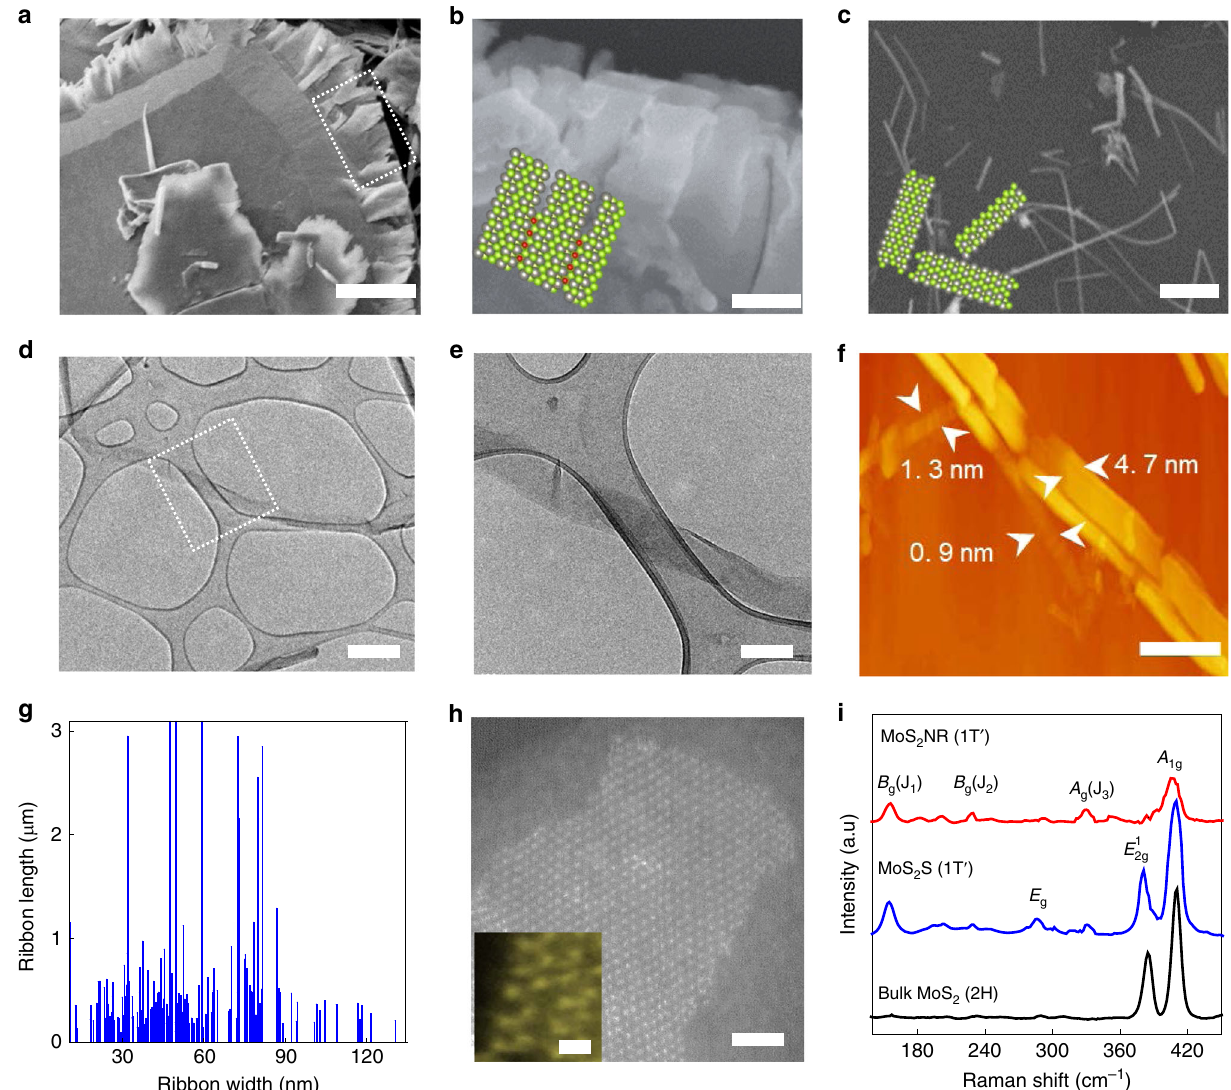
Fig. 1 Unzipping of 2D MX 2 . SEM image of ( a ) unzipped MoS 2 after 5 min of ultrasonication displaying the initiation of unzipping from fl ake edge, ( b ) Magni fi ed image for unzipped edge and ( c ) Fully unzipped MoS 2 displaying discrete MoS 2 NRs. Scale bars, ( a , c ) 0.5 and ( b ) 0.1 µ m. d , e TEM image of isolated MoS 2 NRs. Scale bars, ( d ) 0.2 and ( e ) 0.1 µ m ( f ) AFM image of MoS 2 NRs. Scale bar, 0.2 µ m ( g ) Plot of NR length as a function of width measured by TEM of more than 400 MoS 2 NRs. h STEM image of MoS 2 NR. Inset is the lattice image with low beam exposure displaying 2a0xa0 symmetry and